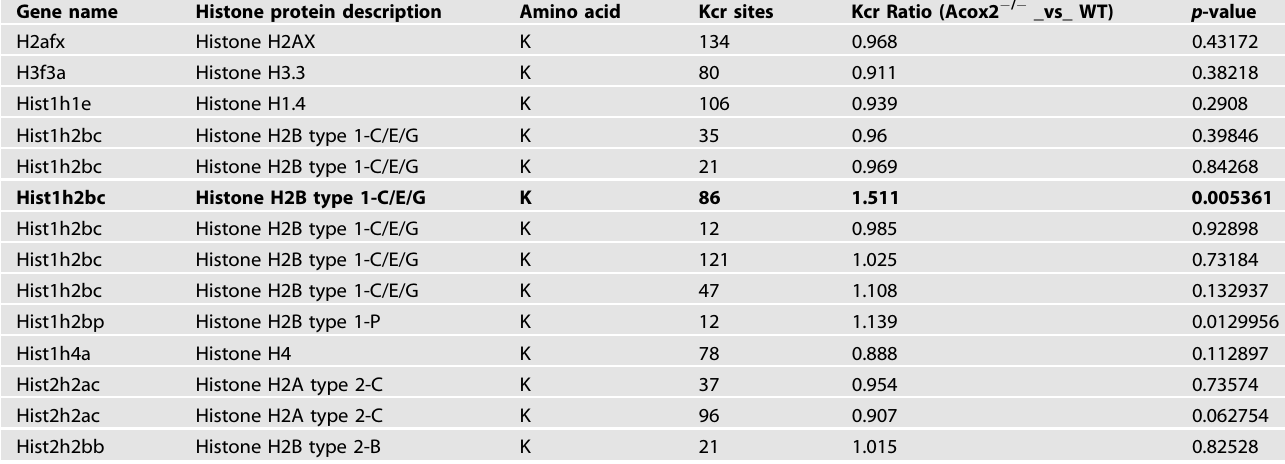
Table 1. 14 Quanti fi able Kcr sites on histone proteins were identi fi ed in Acox2 − / − mice by global crotonylome. Gene